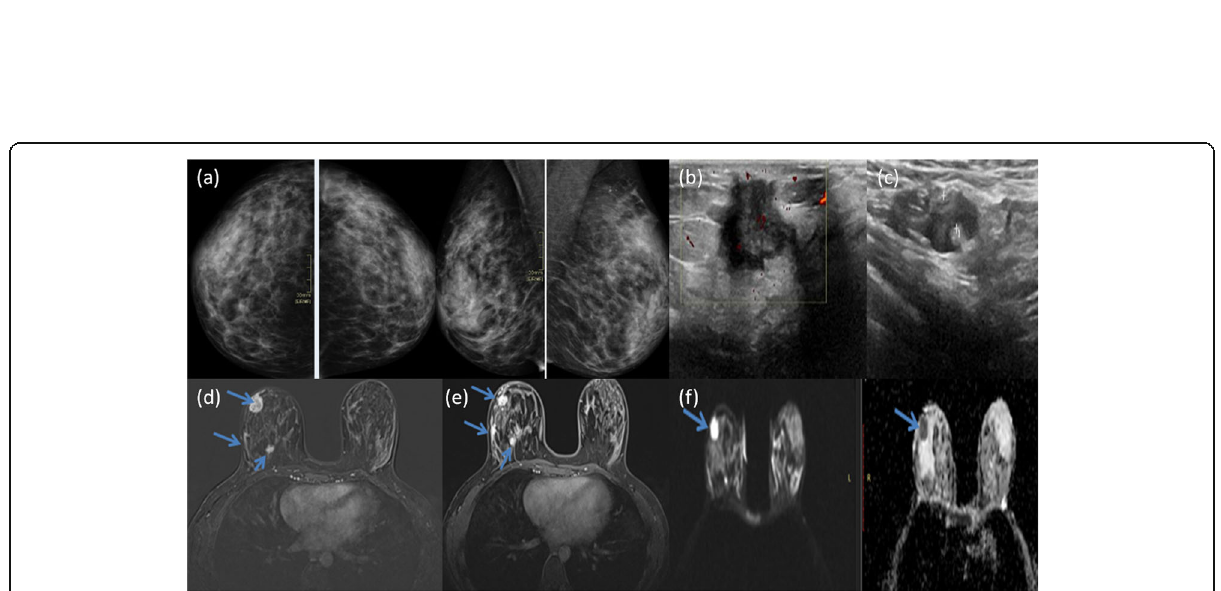
Fig. 5 A case of pathologically proven multicentric IDC with major DCIS component IDC grade II (T2) sentinel lymph node status 1/5(N1). a Mammography showed no spiculated mass lesions or microcalcific clusters. Complementary ultrasound showed b right periareolar 8 o ’ clock ill- defined hypoechoic mass with increased vascularity and c right pathologically enlarged axillary lymph node. d , e DCE-MRI breast revealed a spiculated heterogeneously enhancing mass at 8 o ’ clock in the LOQ. The mass is seen reaching the nipple, associated multiple right breast central and lower quadrants similar enhancing nodules are seen. Lower outer quadrant regional pathological non mass enhancement is seen as well. f DWIs showed restricted diffusion. In this case, breast U/S and DWI-MRI detected a single lesion, while DCE-MRI was able to detect multicentricity of the lesions and correlated the best with the pathological specimen